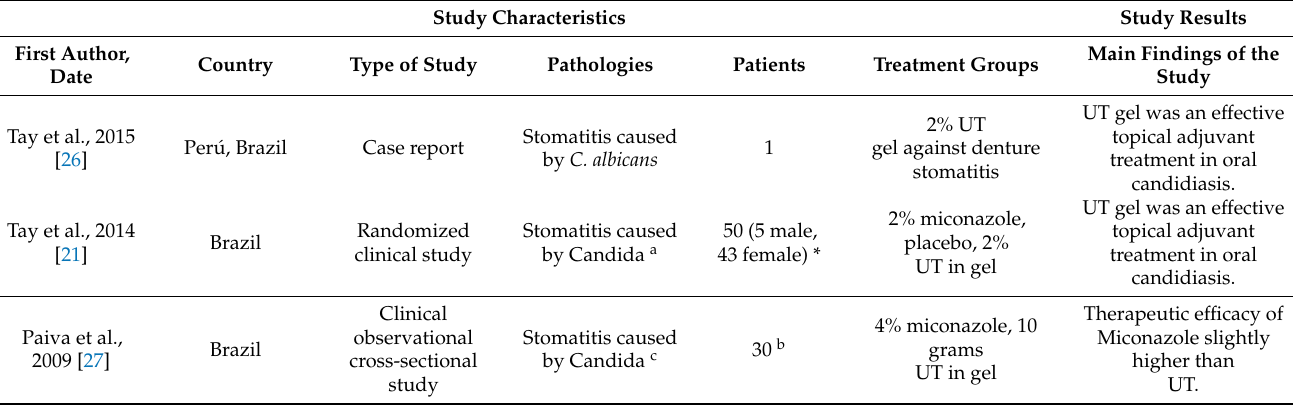
Table 2. Case reports and clinical